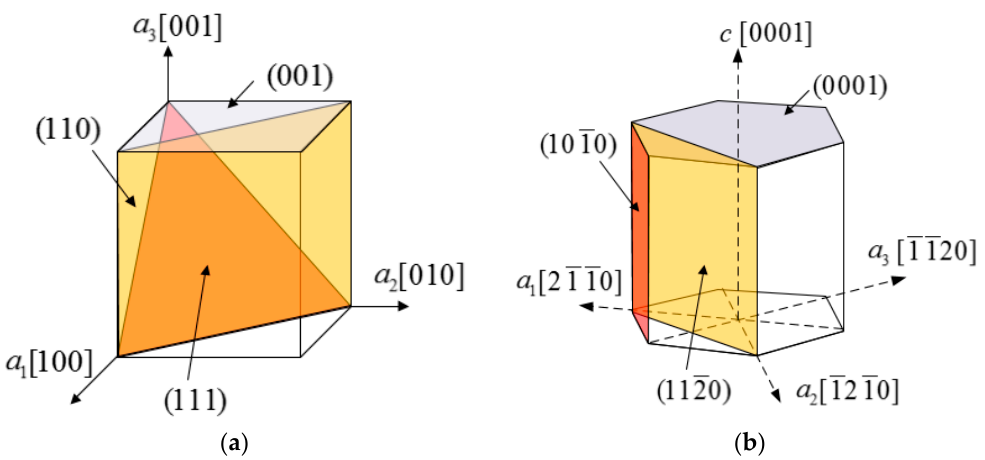
Figure 1. Illustration of ( a ) cubic (001), (110) and (111) surfaces and ( b ) hexagonal (0001), ( 1010 ) and ( 1120 ) surfaces studied in this work.